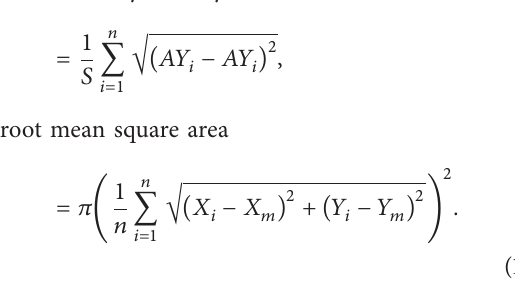
↓↓ Figure 3: Mean reaction time at the different MRs for foot and car stimulus angles in Experiment 1. Error bars depict the standard deviation of the